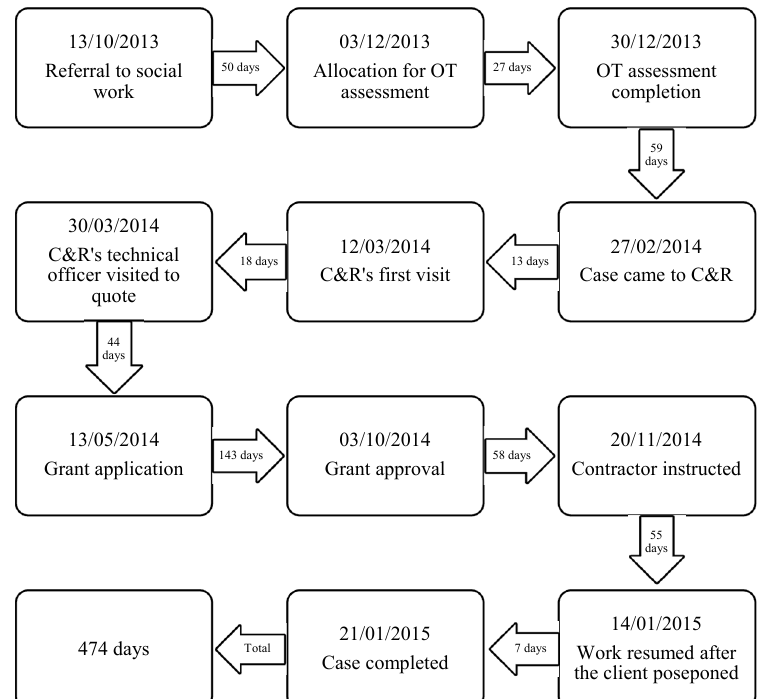
Figure 1. The timeline of the adaptation process for Client A.